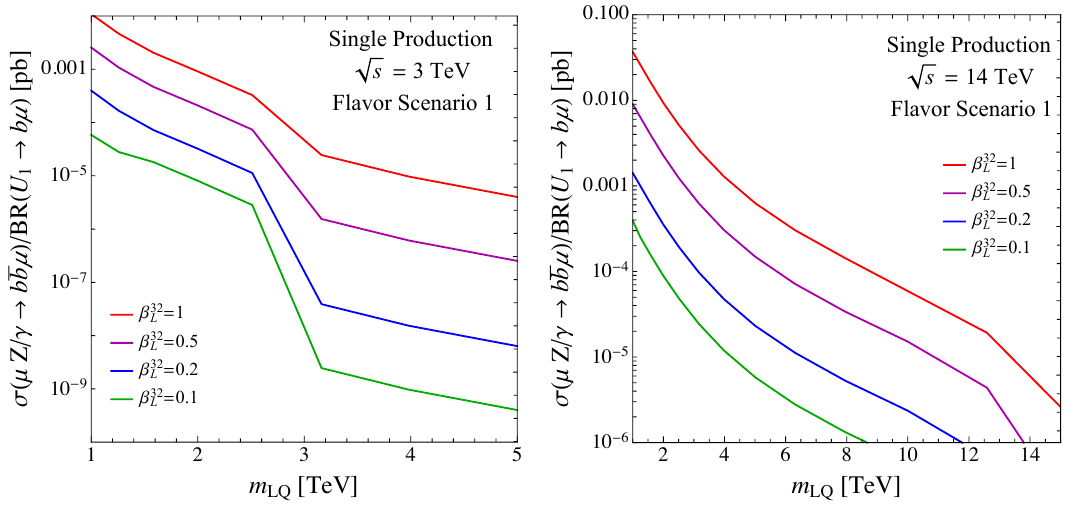
Figure 8 . SP cross section normalized by the branching ratio of the LQ for the U 1 at a COM energy of 3 TeV (left) and 14 TeV (right) for flavor scenario 1. The cross section strongly depends